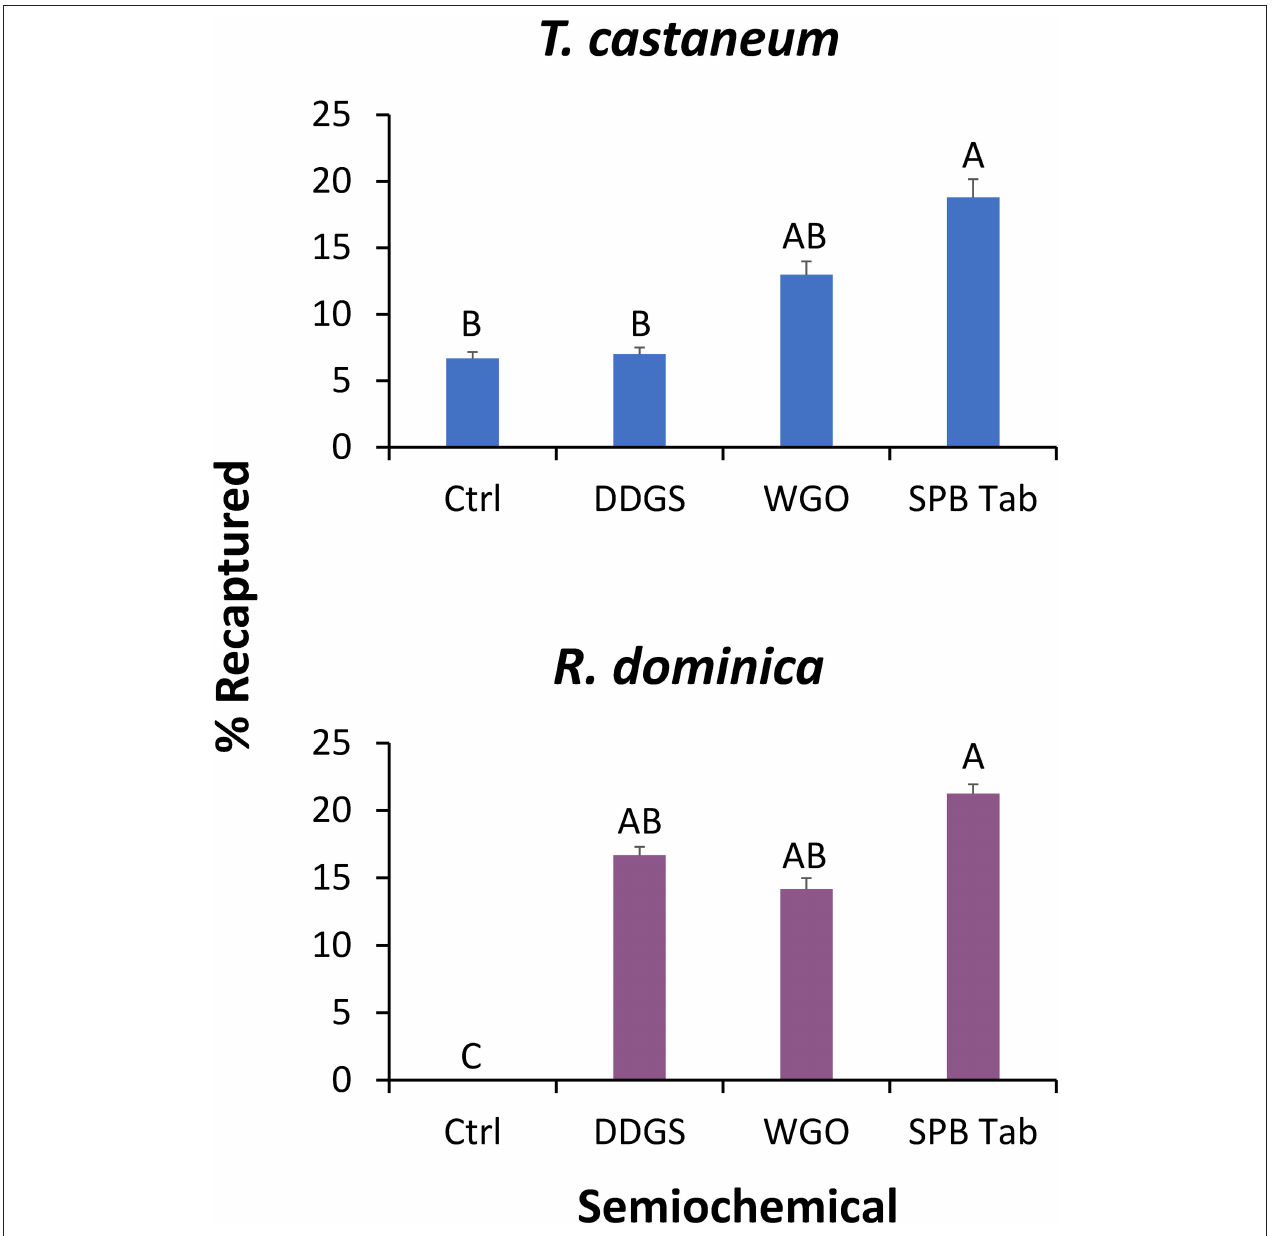
FIGURE 5 | The percentage of T. castaneum (top) and R. dominica (bottom) captured in Trécé Storgard Dome® pitfall traps in a release-recapture assay. Each dome trap contained the dried distillers’ grains with solubles (DDGS), wheat germ oil (WGO), the commercial lure Stored Product Beetle Tab (SPB Tab), or ambient air (Ctrl). Bars with shared letters are not significantly different from each other (Tukey HSD, α =